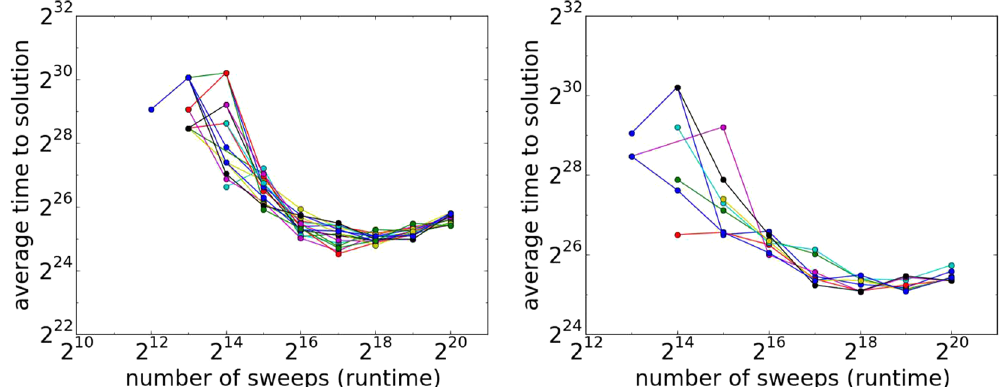
Figure 2. Simulated annealing average time to solution—the ratio of success probability to number of sweeps, vs. number of sweeps for different solutions (log-log scale). Each line represents a different solution. Left: A 504- bit instance with 16 solutions. Right: A 504-bit instance with 4 solutions. For most instances, certain solutions are reached considerably sooner than others.